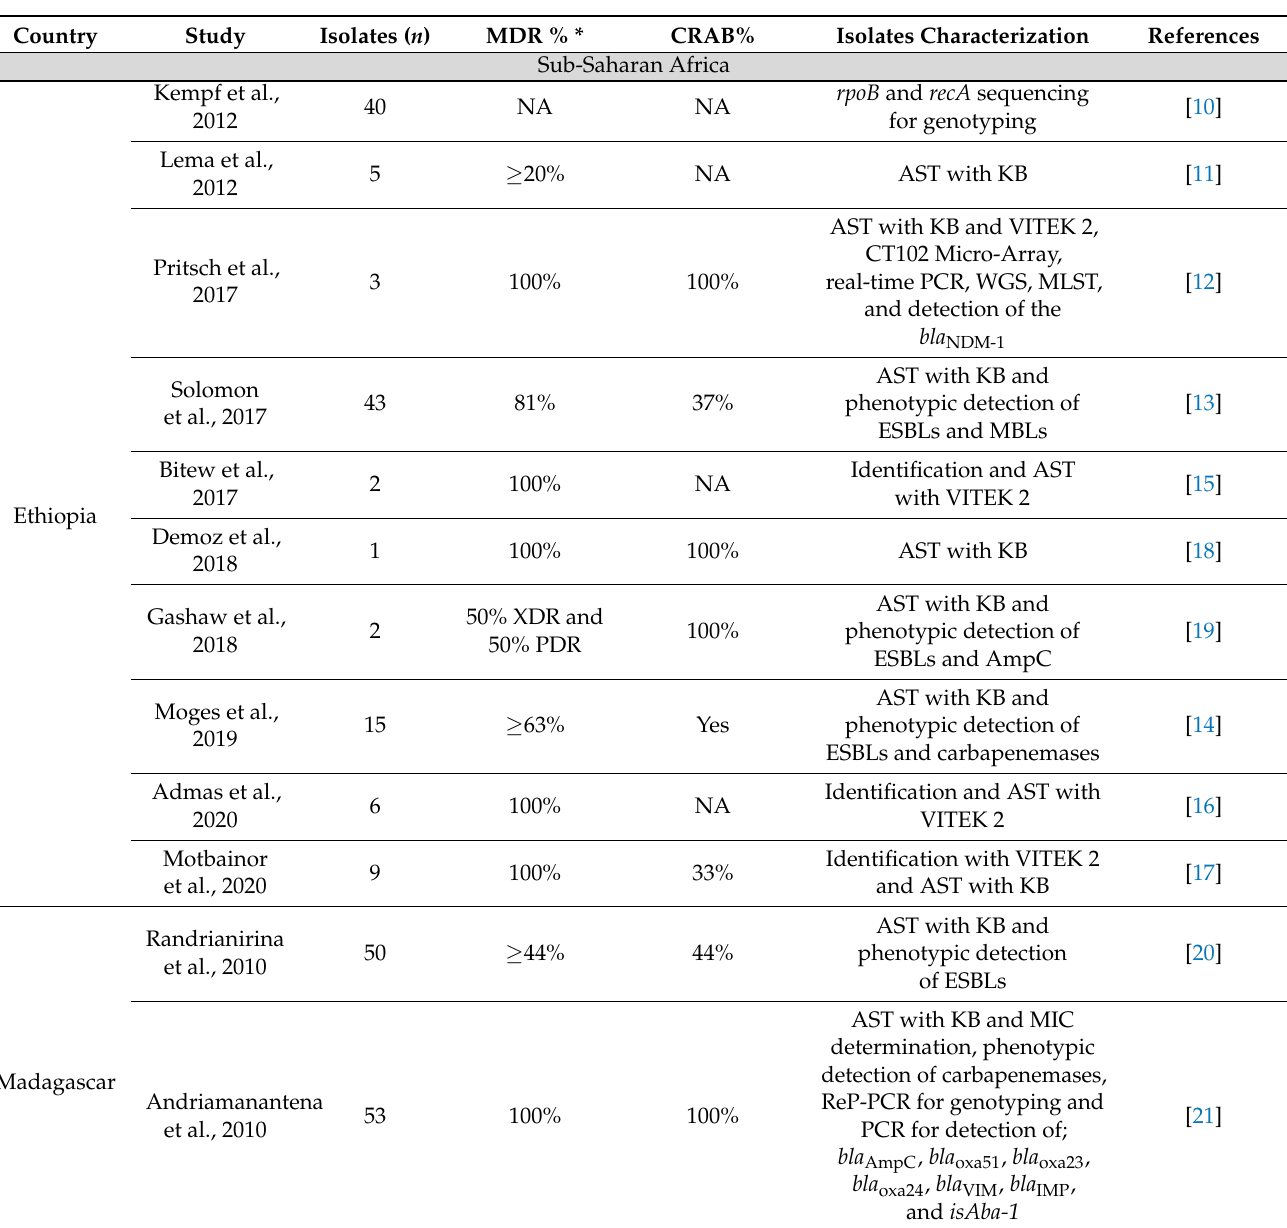
Table 1. A summary of the studies about A. baumannii in LICs from 2000 to